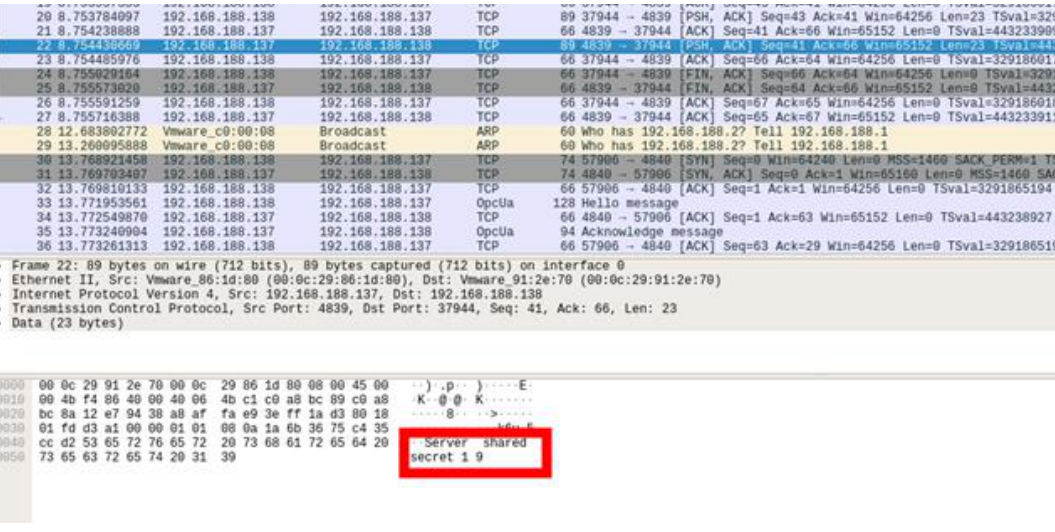
Figure 13. Rogue client eavesdrops on the key exchange process (capturing the “Server shared secret 19” packet).